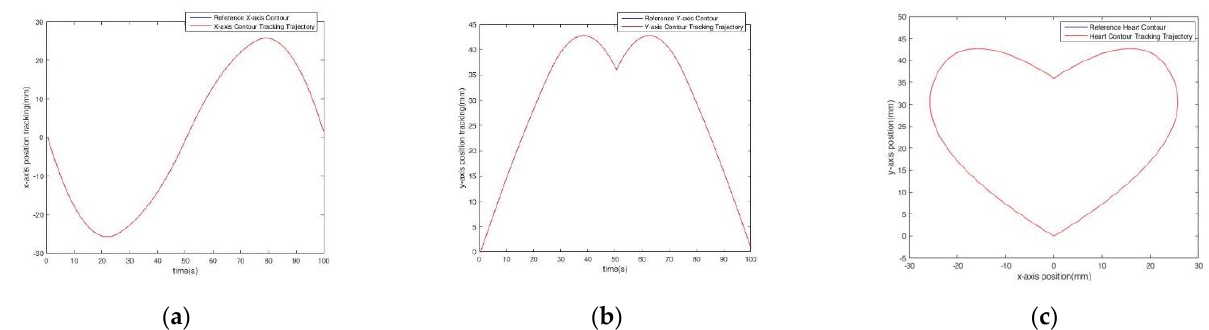
Figure 9. The path trajectory of the simulations. ( a ) The X − axis tracking response, ( b ) the Y − axis tracking response, ( c ) the heart path response.